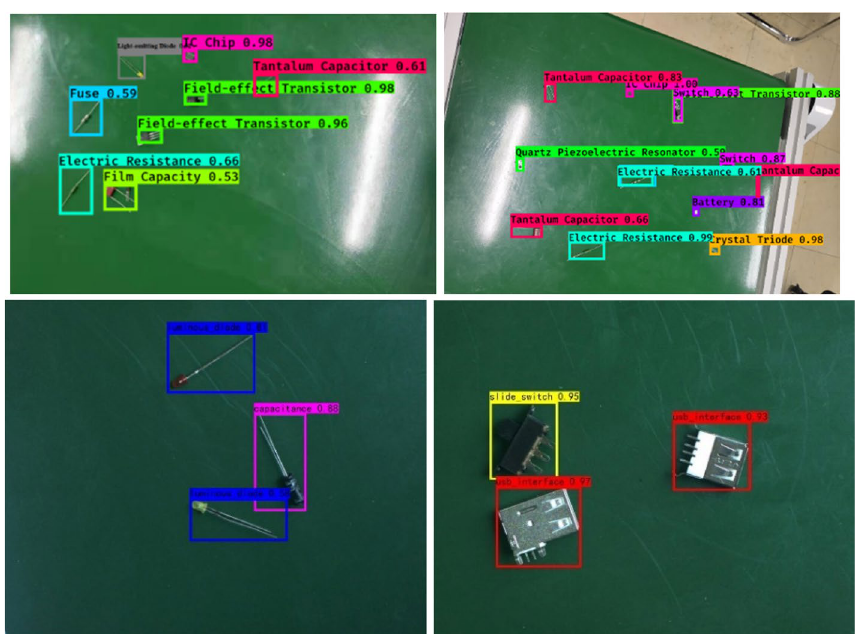
Figure 11. Inspection results of electronic